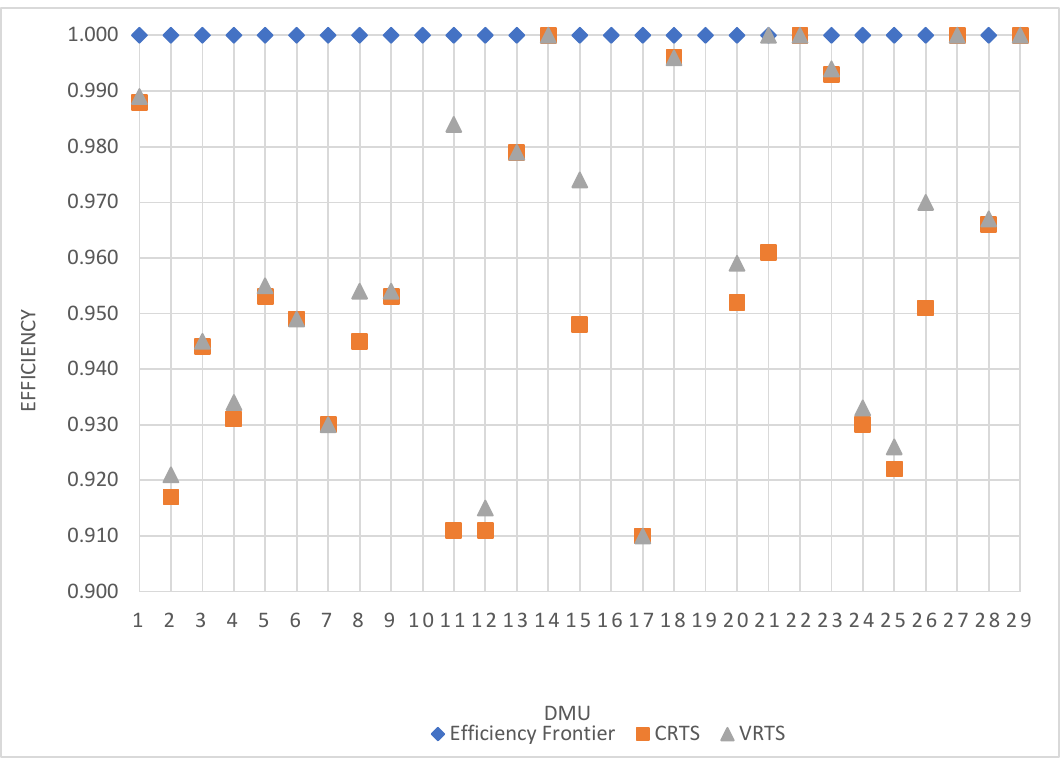
Figure 1. Efficiencies Chart. Figure 1. E ffi ciencies